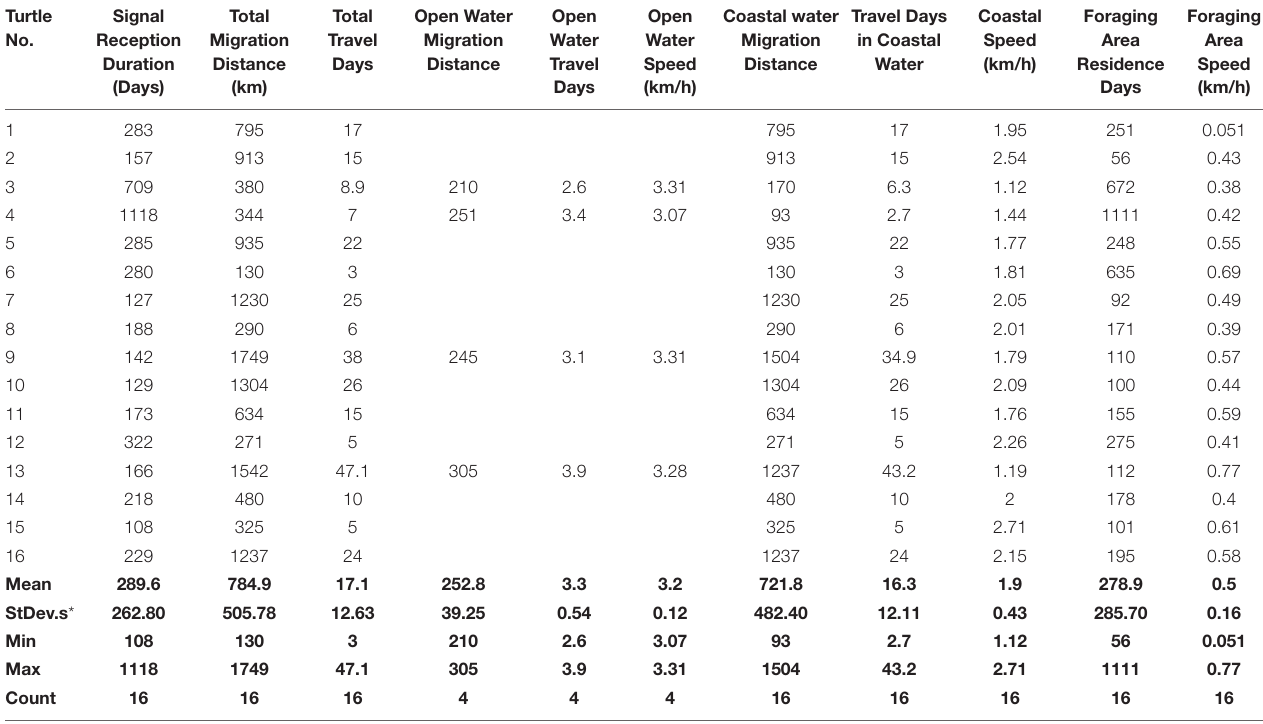
*Stdev.s = Standard Deviation of the Sample. Turtle numbers are shown on Figure 1 . 1542 km. The mean rate of travel of turtles while moving along the coast was 1.9 ± 0.426 km/h ( n = 16, Table 2 ). The mean speed of four turtles while crossing the deep water of the Red Sea was 3.24 ± 0.116 km/h ( n = 4, Table 2 ). The mean speed dropped to 0.49 ± 0.163 km/h ( n = 16, Table 2 ) in the foraging areas.